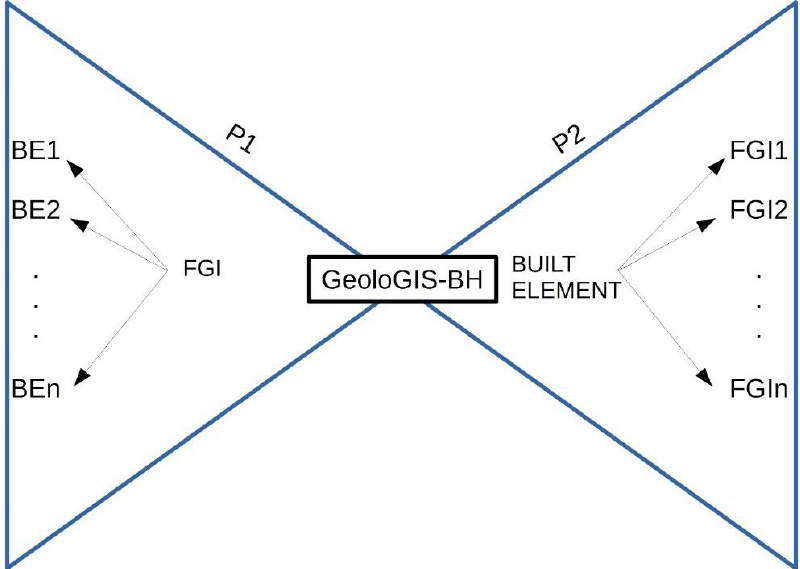
Figure 1. A visual comparison of the two perspectives proposed for the GeoloGIS-BH: in P1 (left side), the feature of geological interest (FGI) is the centre of attention and are registered the built elements where it can be found (BE1 … BEn) while in P2 (right side), the built element is the centre of attention and are registered the features of geological interest that are present on it (FGI1, …,